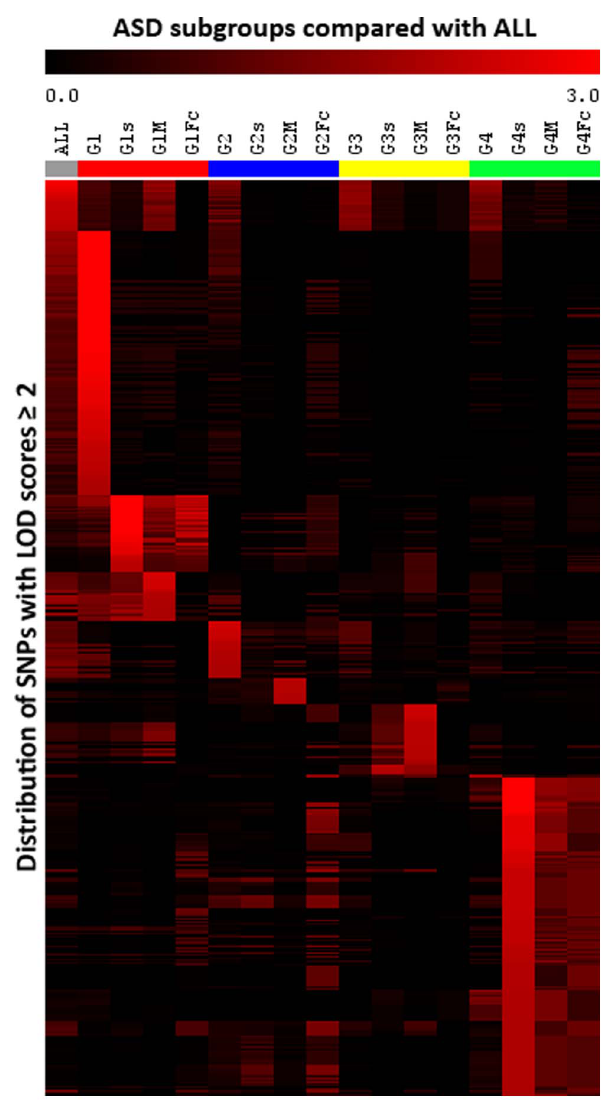
Figure 2. Heat map of LOD scores. A graphical representation (heat map) of the LOD score data (cut-off $ 2.0) was generated to visually demonstrate the computed linkage scores for each subgroup in a hierarchy. The heat map compares LOD score patterns for the 16 subgroups. As expected, there were more similarities within each ADI-R group (e.g., G1, G1s, G1M, and G1Fc) than between two different ADI-R groups. Each horizontal band represents a SNP while each column represents a stratified subgroup, with the exception of the first column which represents the combined (ALL) cohort. Table S4 in File S2 lists the SNPs and LOD scores contributing to the identified segregation patterns by subgroups (i.e., hot spots). The corresponding genomic positions of the SNPs contributed to the heat map (Y-axis) are listed in Table S4 in File S2 . The heat map was generated using MeV software [41].